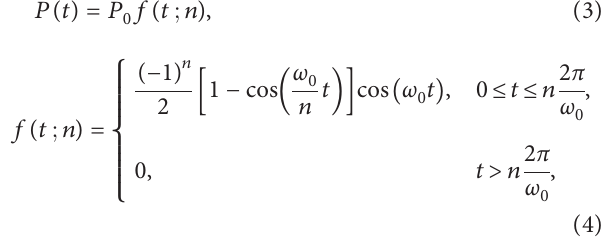
Figure 2. It used the mode of sweep from top to